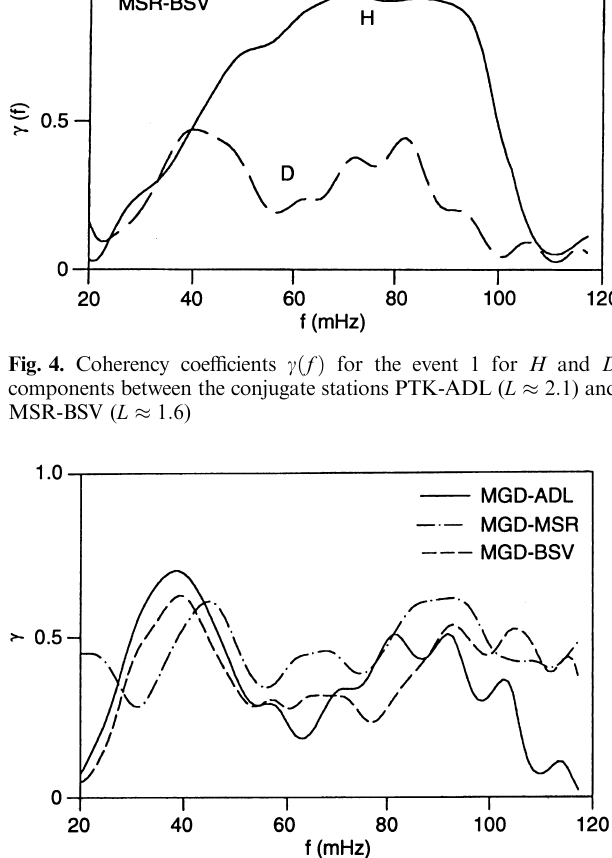
Fig. 5. Coherency coe(cid:129)cients c (cid:133) f (cid:134) for the event 1 for D component between stations with di(cid:128)erent L -values